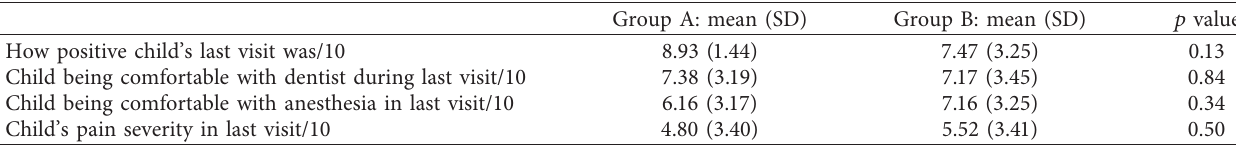
Table 2: Dental history.